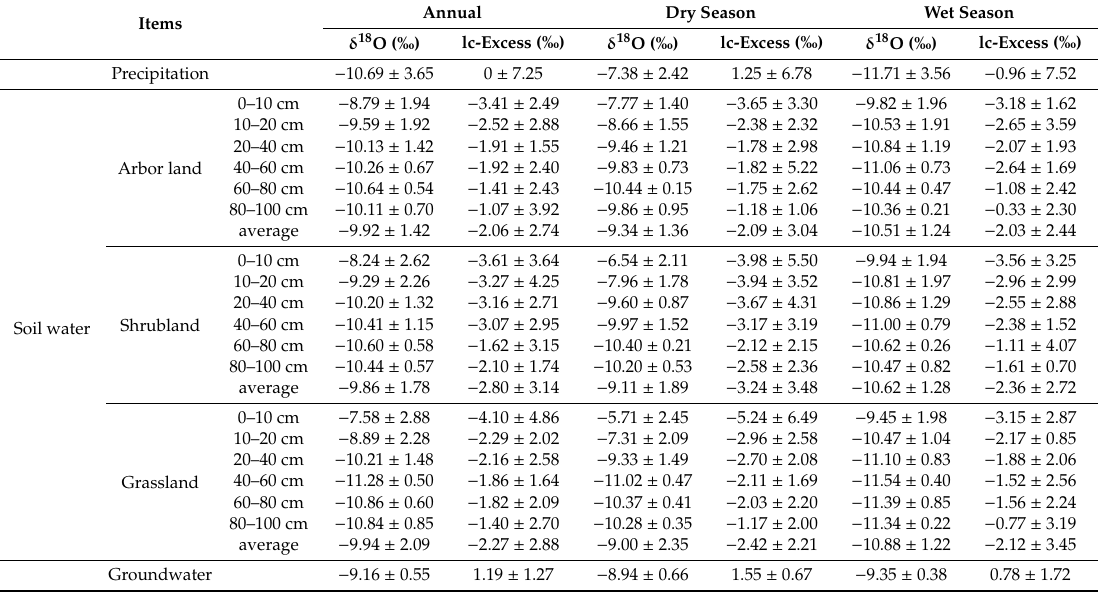
Table 3. Statistics list of stable isotopes in precipitation, soil water, and